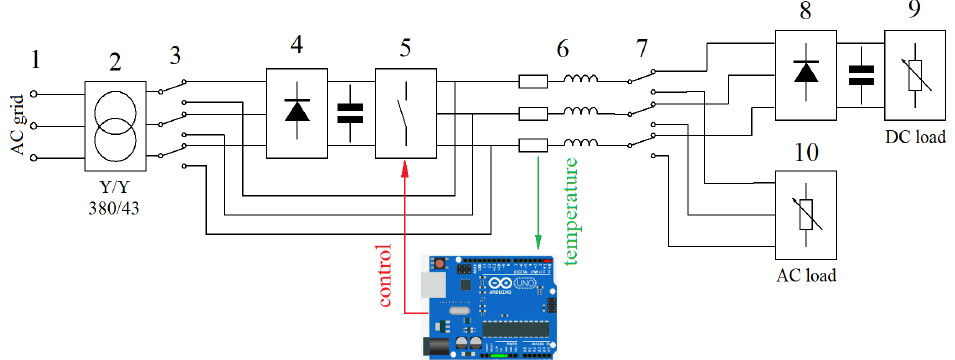
Figure 6. Lab bench scheme: (1) voltage input; (2) 380/43 transformer; (3) bypass switch; (4) trans- mitting end rectifier; (5) switching circuit; (6) line resistances and inductances; (7) switch between AC and DC load units; (8) receiving end rectifier with smoothing capacitor; (9) adjustable DC load unit; (10) adjustable AC load unit.